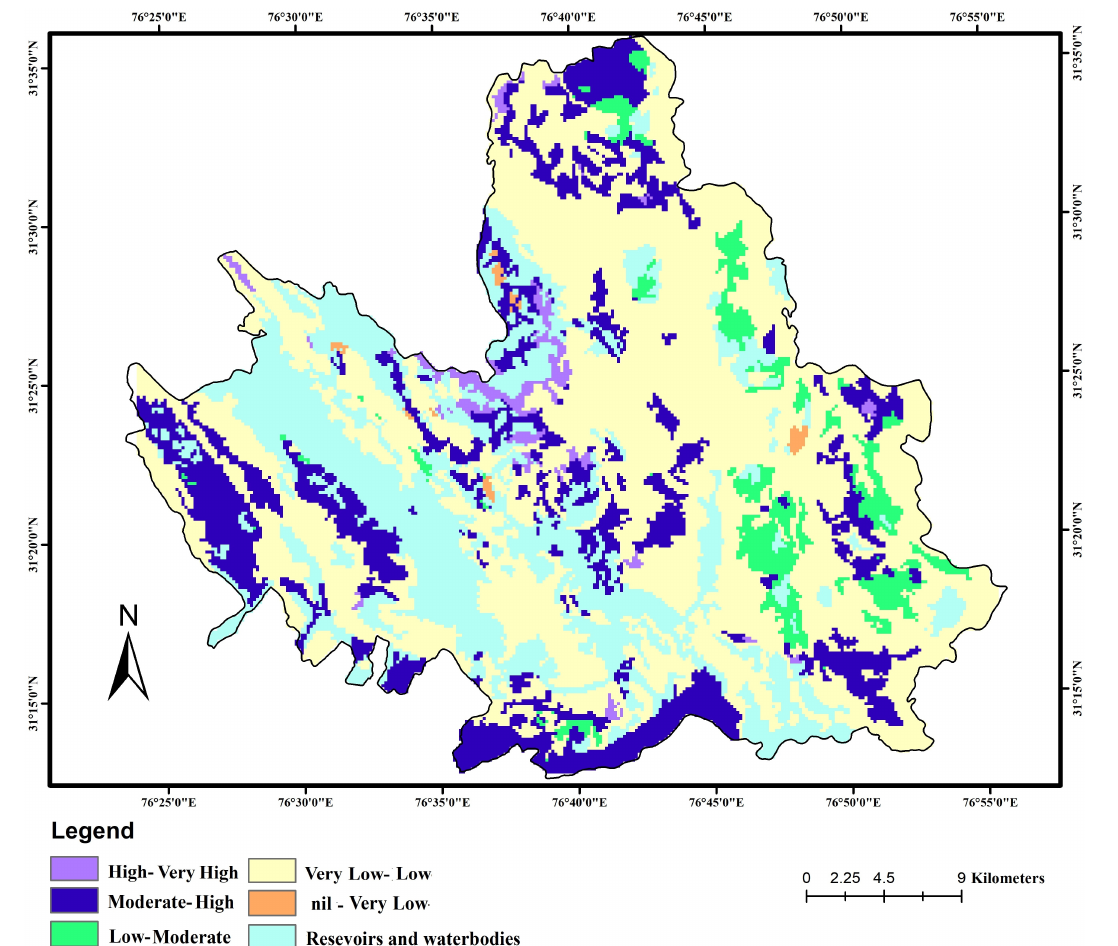
Figure 14. Groundwater potential zone map of study area, Bilaspur.